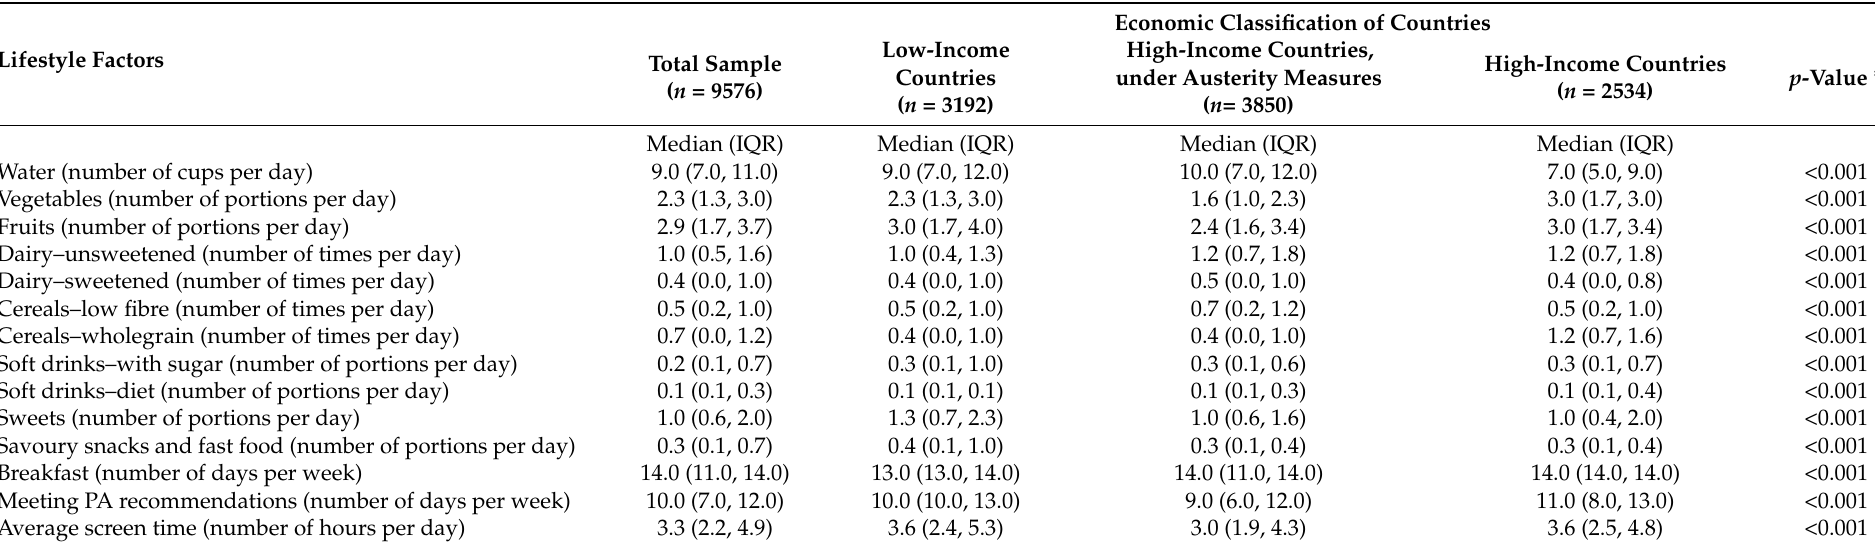
Table 2. Dietary intake, physical activity levels, and screen time of families in the total sample and by economic classification of